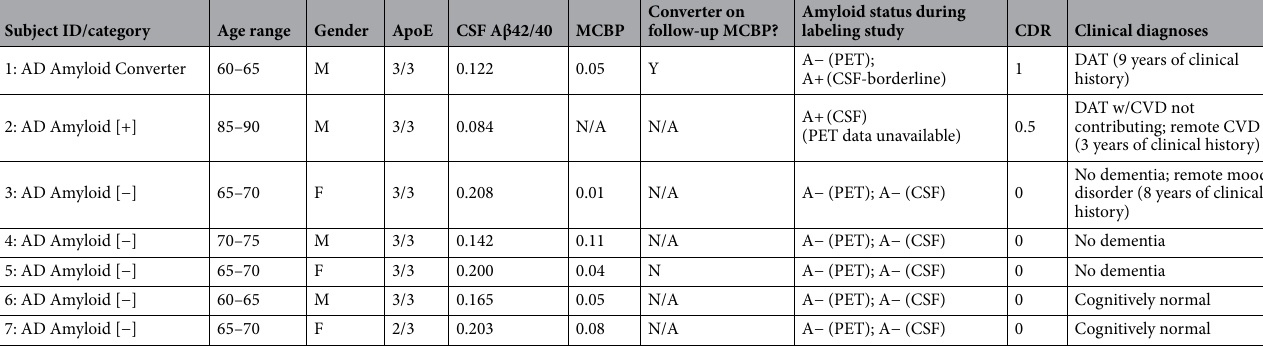
Table 1. Participant characteristics. MCBP score < 0.18 or CSF Aβ 42 /Aβ 40 ratio > 0.12 is classified as Amyloid [−]. Aβ amyloid-beta, AD Alzheimer’s disease, ApoE apolipoprotein E, CSF cerebrospinal fluid, MCBP